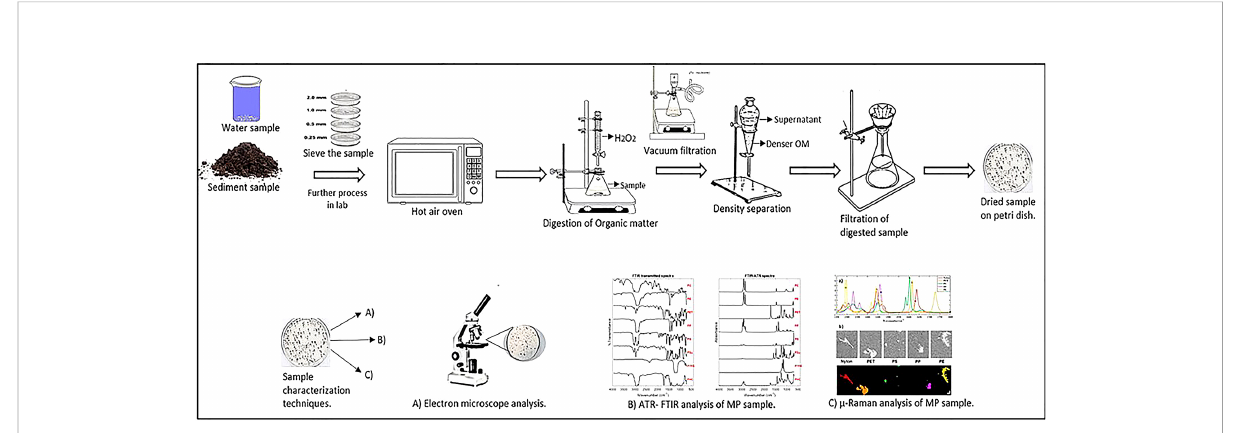
FIGURE 5 Schematic representation of various methods for analysis of MPs. Number of studies identifying the polymer type: 61 out of 74 studies reported polymer type.